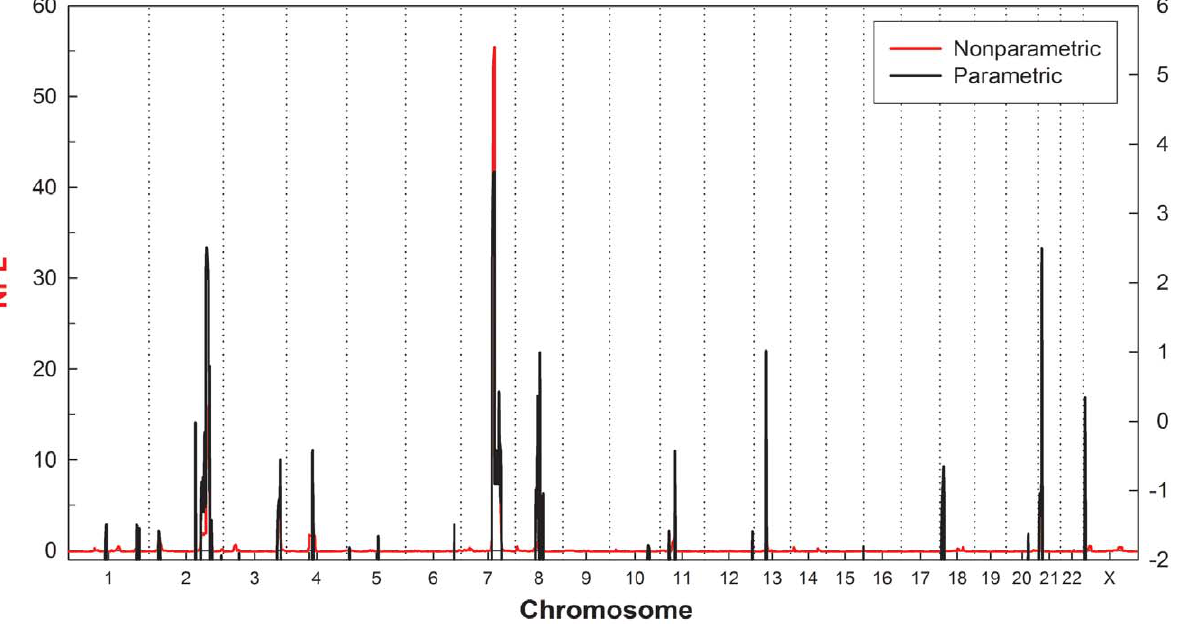
Figure 4. The multipoint parametric and nonparametric linkage scores across the genome. The nonparametric linkage (NPL) scores are shown in red on the left vertical axis, and the parametric LOD scores assuming a dominant inheritance are shown in black on the right vertical